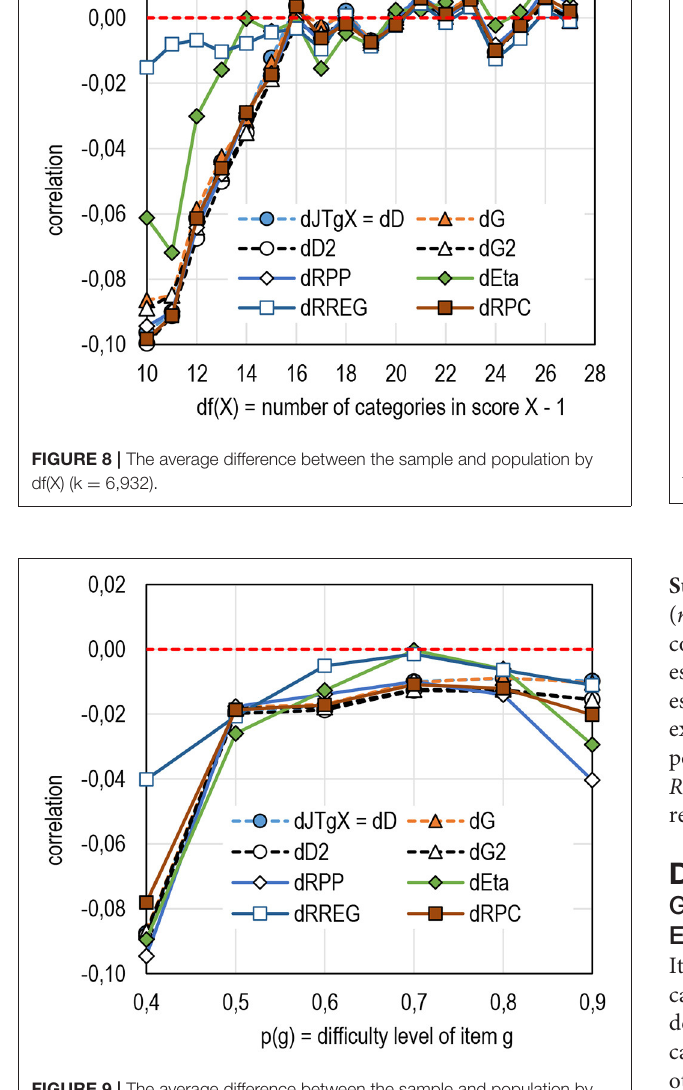
not include polytomous items, with an extreme difficulty level;